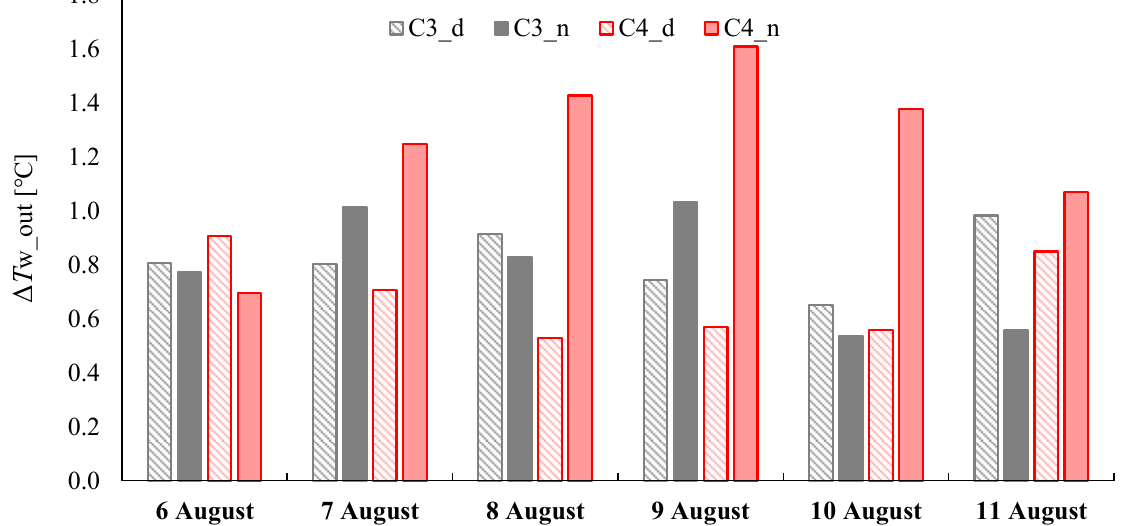
Figure 7. Average difference in outer wall surface temperature between rooms during the day (C3_d, C4_d) and night (C3_n, C4_n) (6-C3 vs. 8-C3, 6-C4 vs. 8-C4).